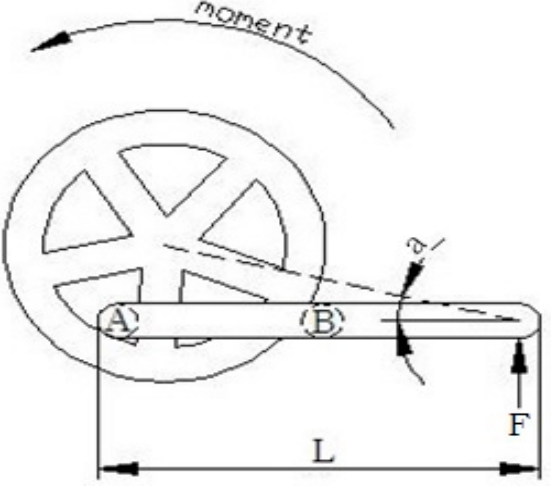
Figure 1. F-spanner concept. The force arm of this structure does not pass through the torque center, and there is a deviation of the angle a, which causes loss of power. Angle a increases with the distance between the two points AB. The larger the angle a, the more serious the loss of power. To improve the inconvenience of the traditional F-spanner and to meet the needs of